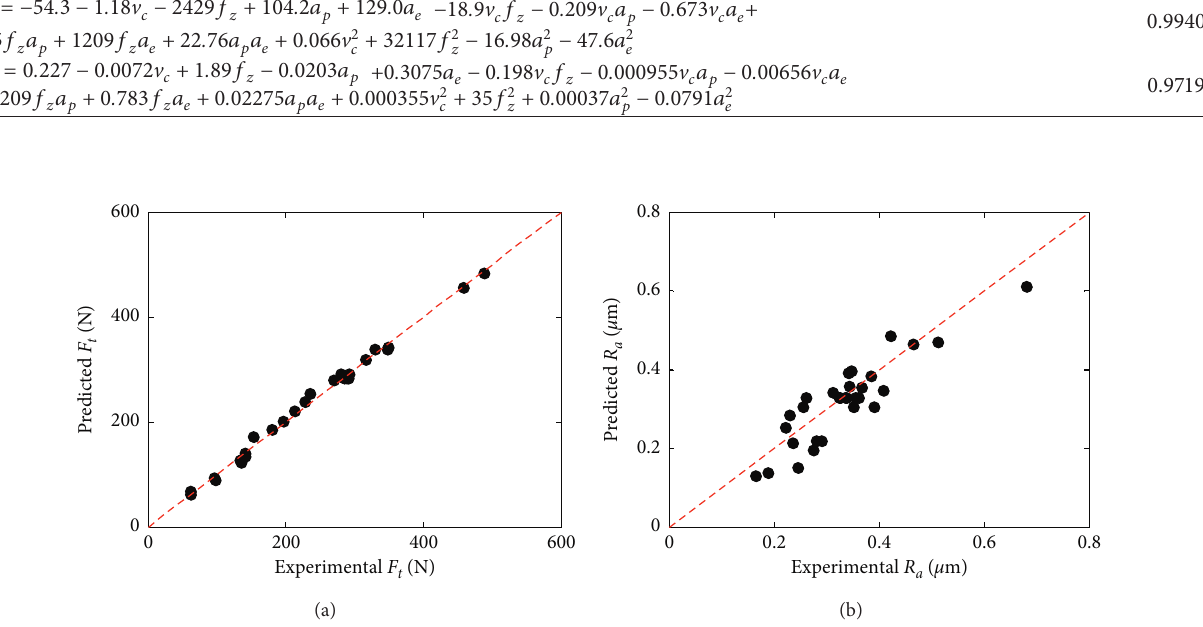
Regression models